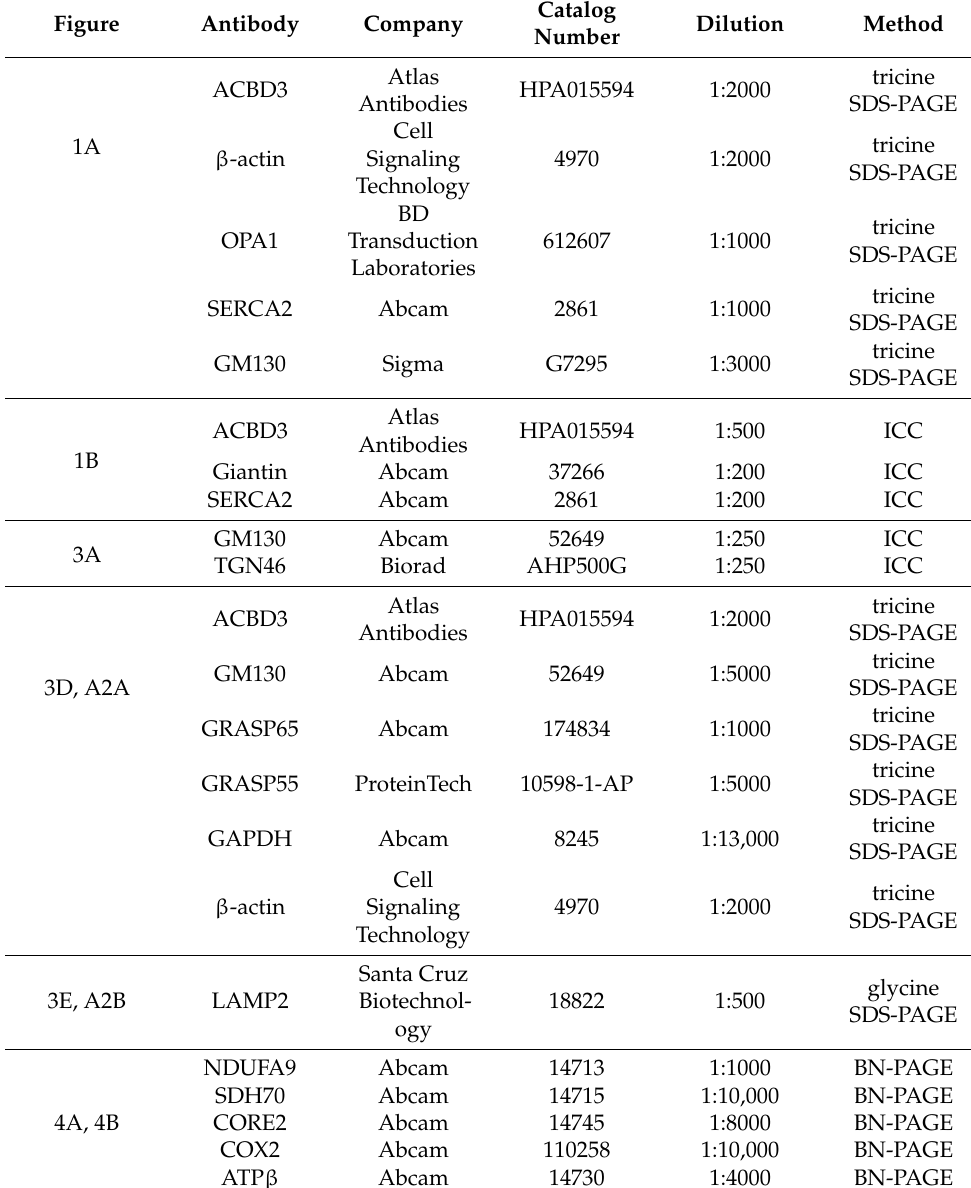
Table A3. Summary of antibodies used in experiments.